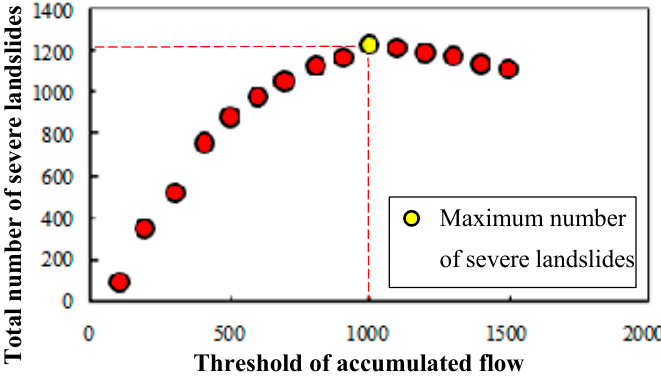
Figure 4. Maximizing the total number of severe landslides to determine the optimum threshold of accumulated flow, and hence the optimum sub-watershed.